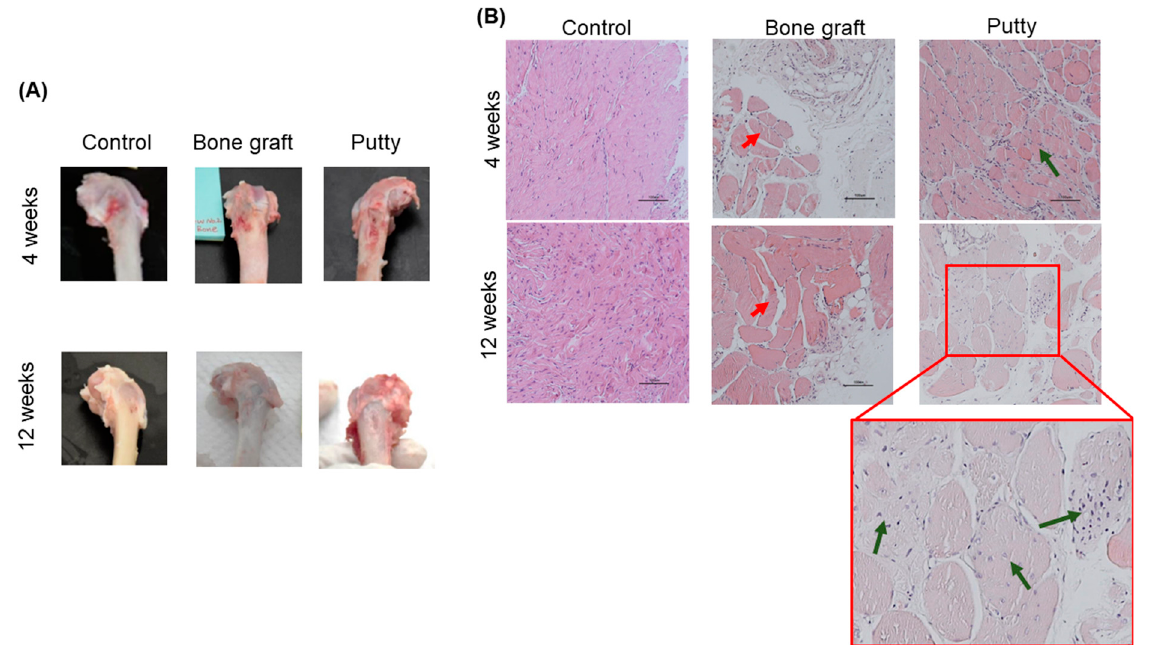
Figure 6. Macroscopic and microscopic assessment of critical-sized bone defect repair in rabbit femurs. ( A ) Representative gross images of the femoral condyle of the critical-sized bone defect. ( B ) Representative femoral sections were stained with Hematoxylin and of the critical-sized bone defect (Scale bar: 200 μ m). The red arrow indicates bone granules. Green indicates bone granules with new bone formations.